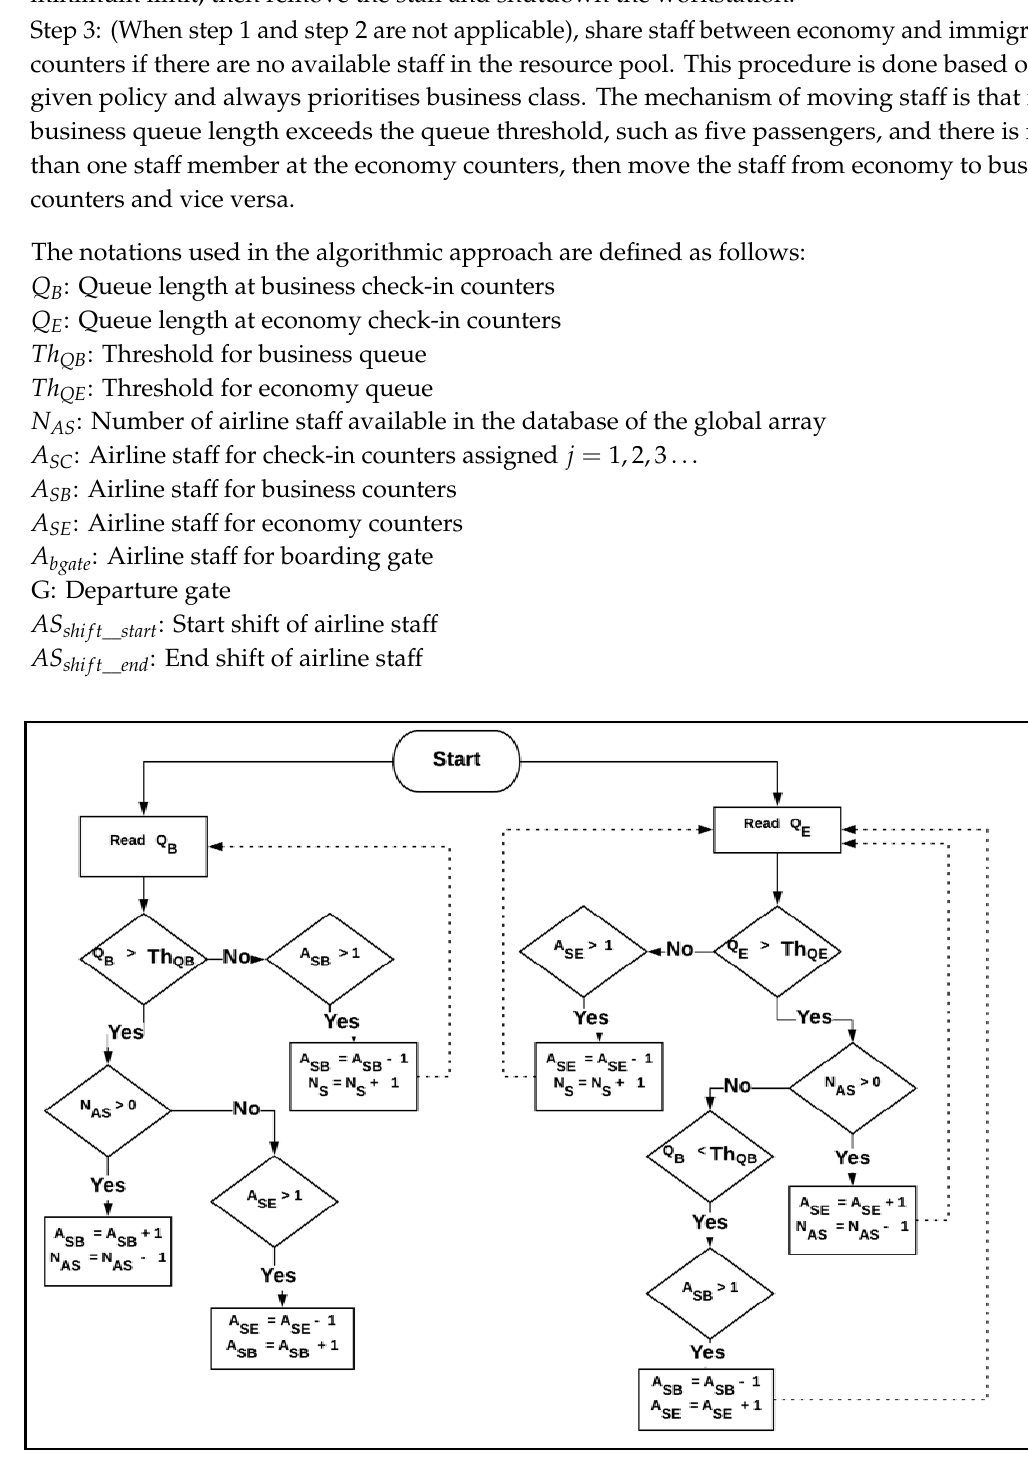
Figure 4. Algorithmic approach for airline staff allocation module.